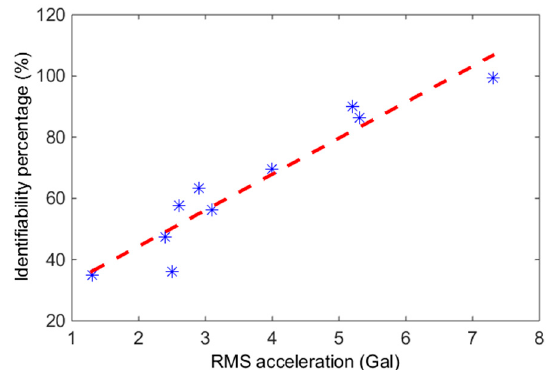
Figure 11. The relationship between the average RMS acceleration value and the identifiability percentage of each month with the blue stars representing data and the red dashed line representing the simple linear regression result.